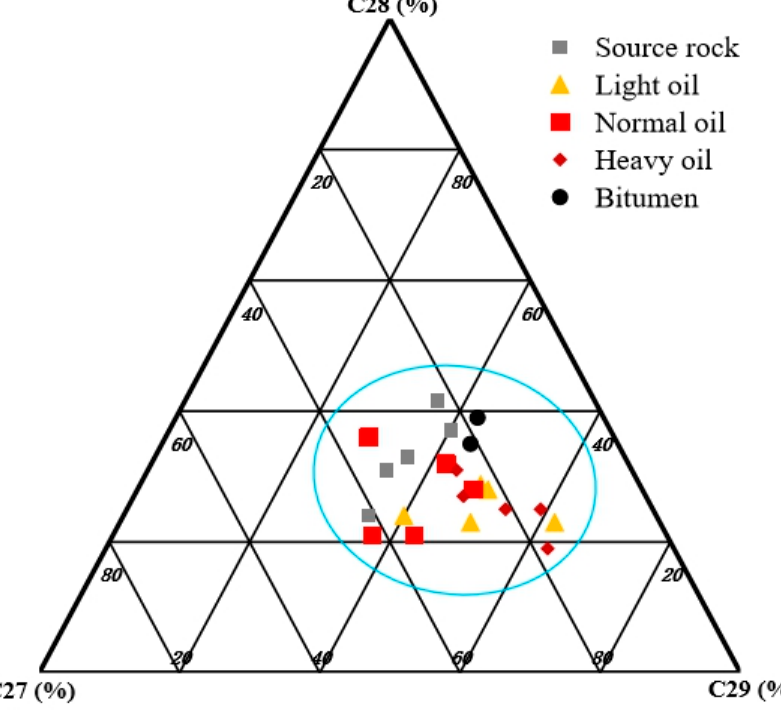
Figure 7. Diagram of C 27 -C 28 -C 29 regular sterane content of source rocks and crude oil samples in Wuerhe area, showing a high content of C 29 regular steranes.